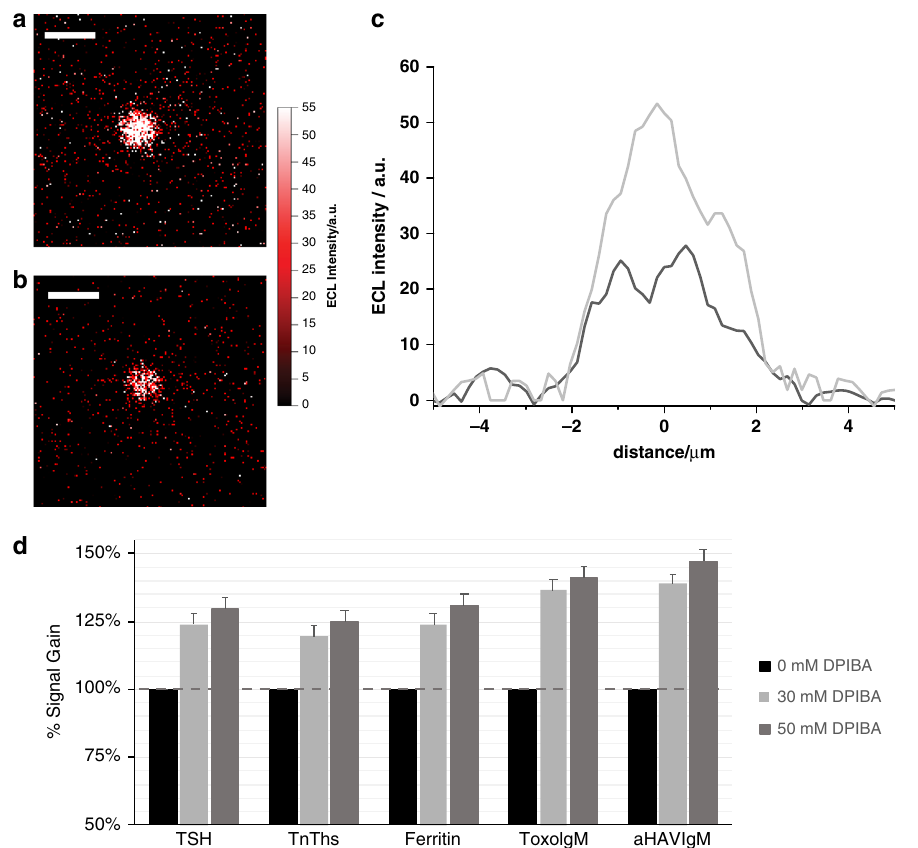
Fig. 4 Bead-based assay and commercial immunoassay using N-dipropyl isobutyl amine (DPIBA). Electrochemiluminescence (ECL) imaging of a 2.8- μ m single bead was obtained by applying a constant potential of 1.4 V (vs. Ag/AgCl) for 4 s in 180 mM tri- n -propylamine (TPrA) and 0.2 M phosphate buffer (PB) with a 50 mM DPIBA and b without DPIBA. Integration time, 4 s; magni fi cation, ×100; Scale bar, 5 μ m. c Comparison of the bead pro fi le lines (black, without DPIBA; and gray, with DPIBA). d ECL signal gain observed in the presence of 30 and 50 mM DPIBA in 180 mM TPrA, 0.2 M PB, and 0.1% polidocanol compared with a reference buffer without DPIBA, as measured on a Roche Diagnostics Cobas e 801 immunoassay analyzer using the Elecsys ® assays thyroid stimulating hormone (TSH), cardiac troponin T (TnT hs), Ferritin, Toxoplasma gondii IgM (Toxo IgM), and hepatitis A IgM (A ‐ HAV IgM) and a biomarker containing calibrator as sample. Error bar shows the standard deviation ( n =